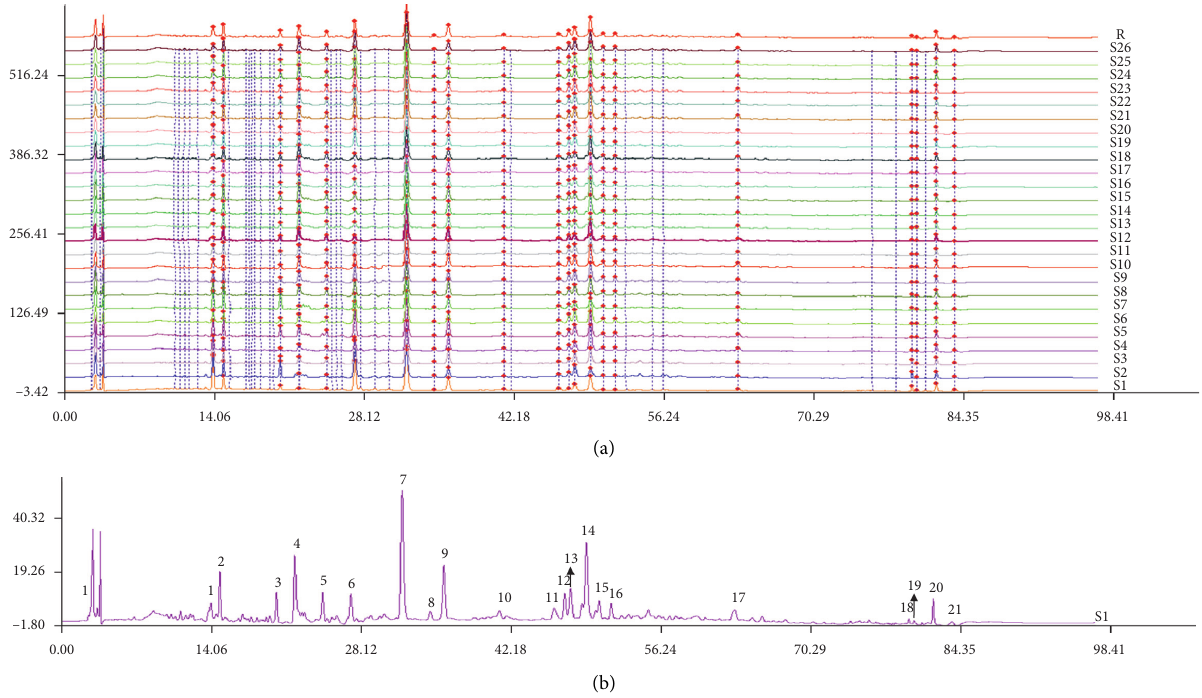
Figure 3: HPLC fingerprint of 26 batches of V. anthelmintica samples (a) and the reference fingerprint of V. anthelmintica .